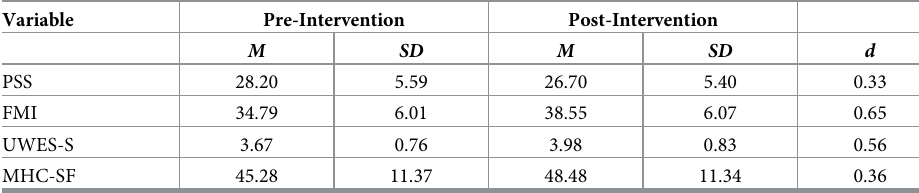
Table 1. Descriptive statistics for PSS, FMI, UWES-S, and MHC-SF scores at pre- and post-intervention.